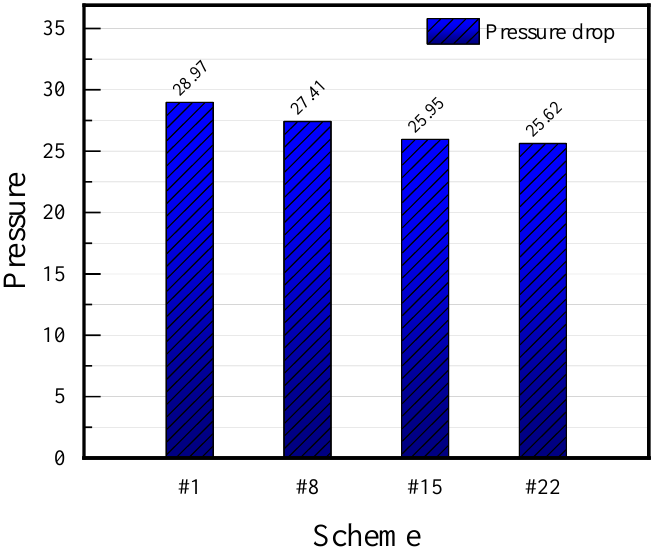
Figure 16. The pressure drop in the cathode flow field between schemes #1, #8, #15 and #22.